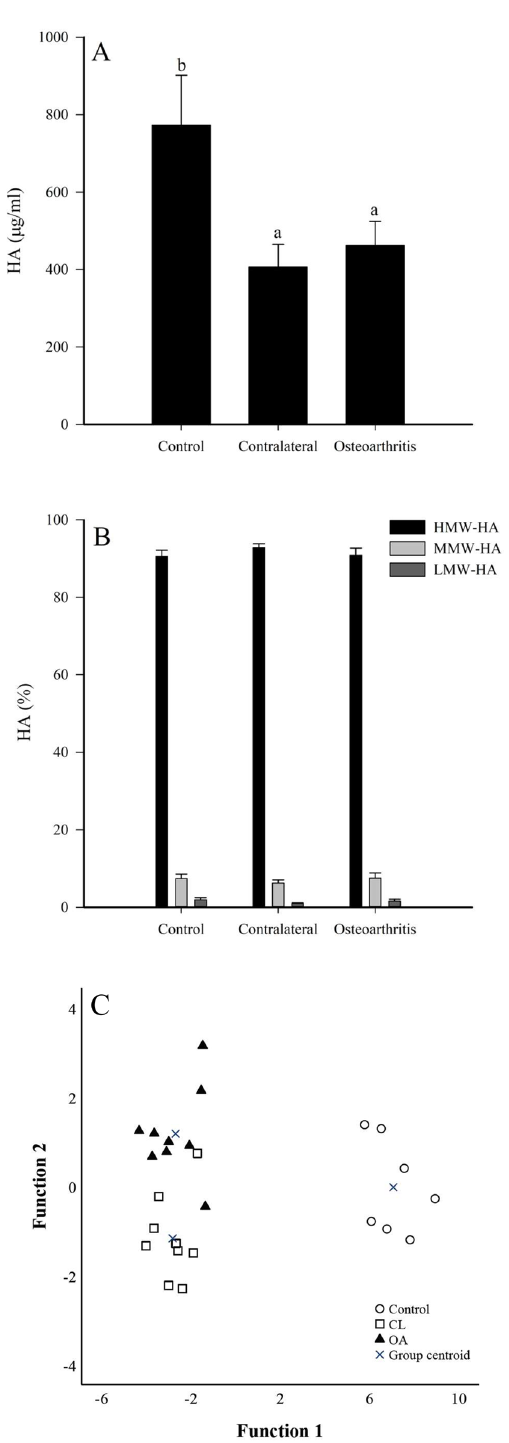
Figure 6. Total hyaluronan (HA) concentrations ( A ) and size distribution ( B ) in equine synovial fluids from control, contralateral (CL), and osteoarthritic (OA) fetlock joints (means + SE). Bars with dissimilar lowercase letters differ significantly from each other (generalized linear model, p < 0.05). Discriminant analysis ( C ) depicting the classification of HA data in equine synovial fluids based on discriminant functions 1 (on x-axis) and 2 (y-axis) that together explain 100% of the variance in the dataset. HMW = high-molecular-weight (≈2500 kDa), MMW = medium-molecular-weight (≈500 kDa), LMW = low-molecular-weight (≈150